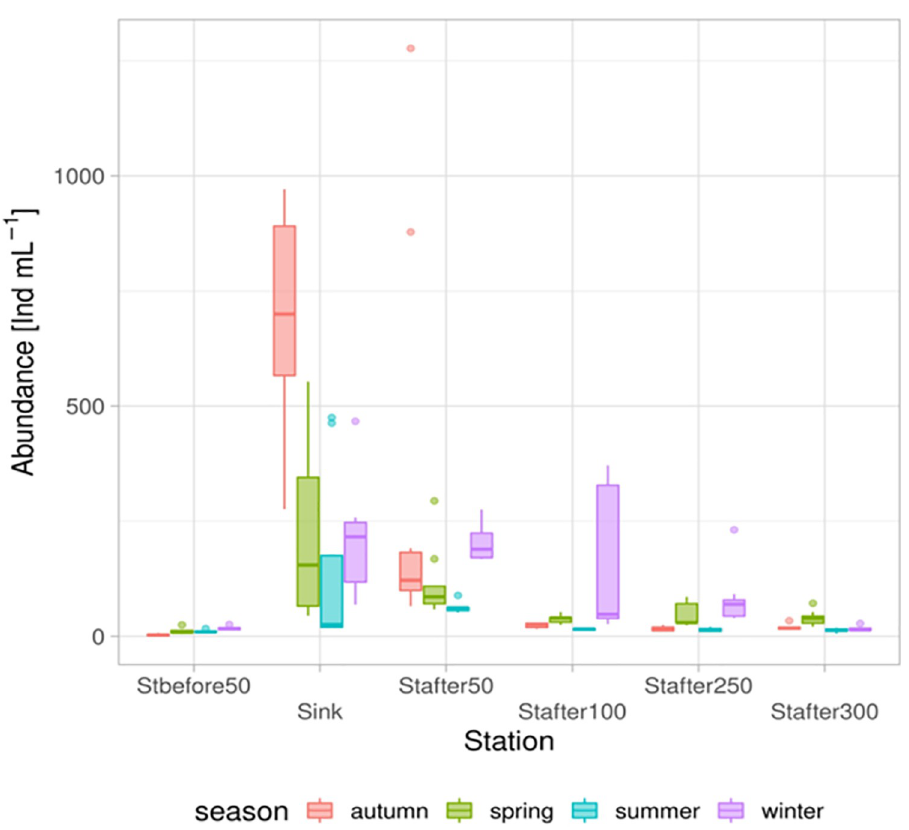
Fig 3. Seasonal changes in the abundance of ciliates by stations in an environmental gradient based on data for the entire study